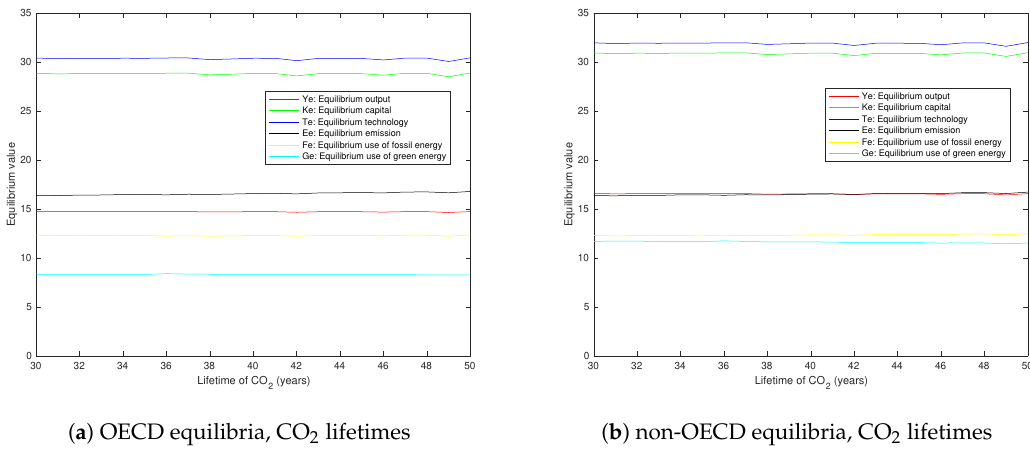
Figure 11. Equilibrium values, CO 2